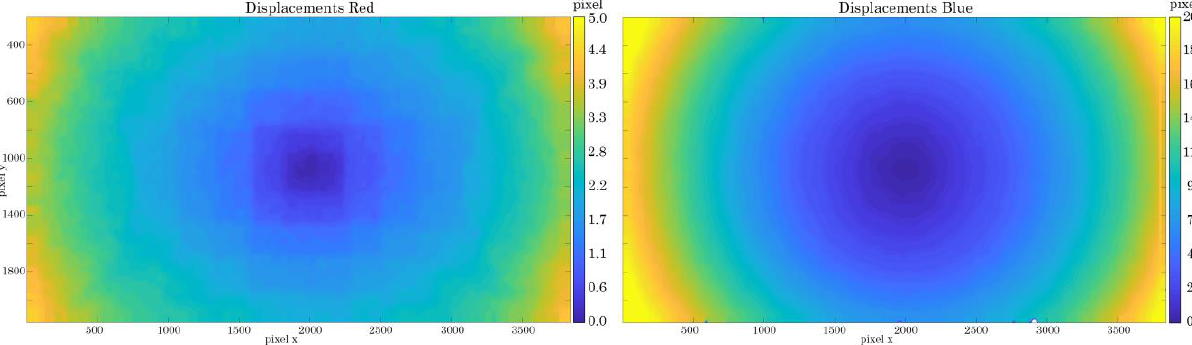
Figure 3. Estimated displacements of red (left) and blue (right) channel features with respect to the green channel. Note the scale difference: a maximum displacement of about 4 pixel was obtained for the red channel, whereas a maximum displacement of more than 20 pixel was found for the blue channel. The block-like structure in the red channel is an effect of the median filtering of all estimated displacements in this